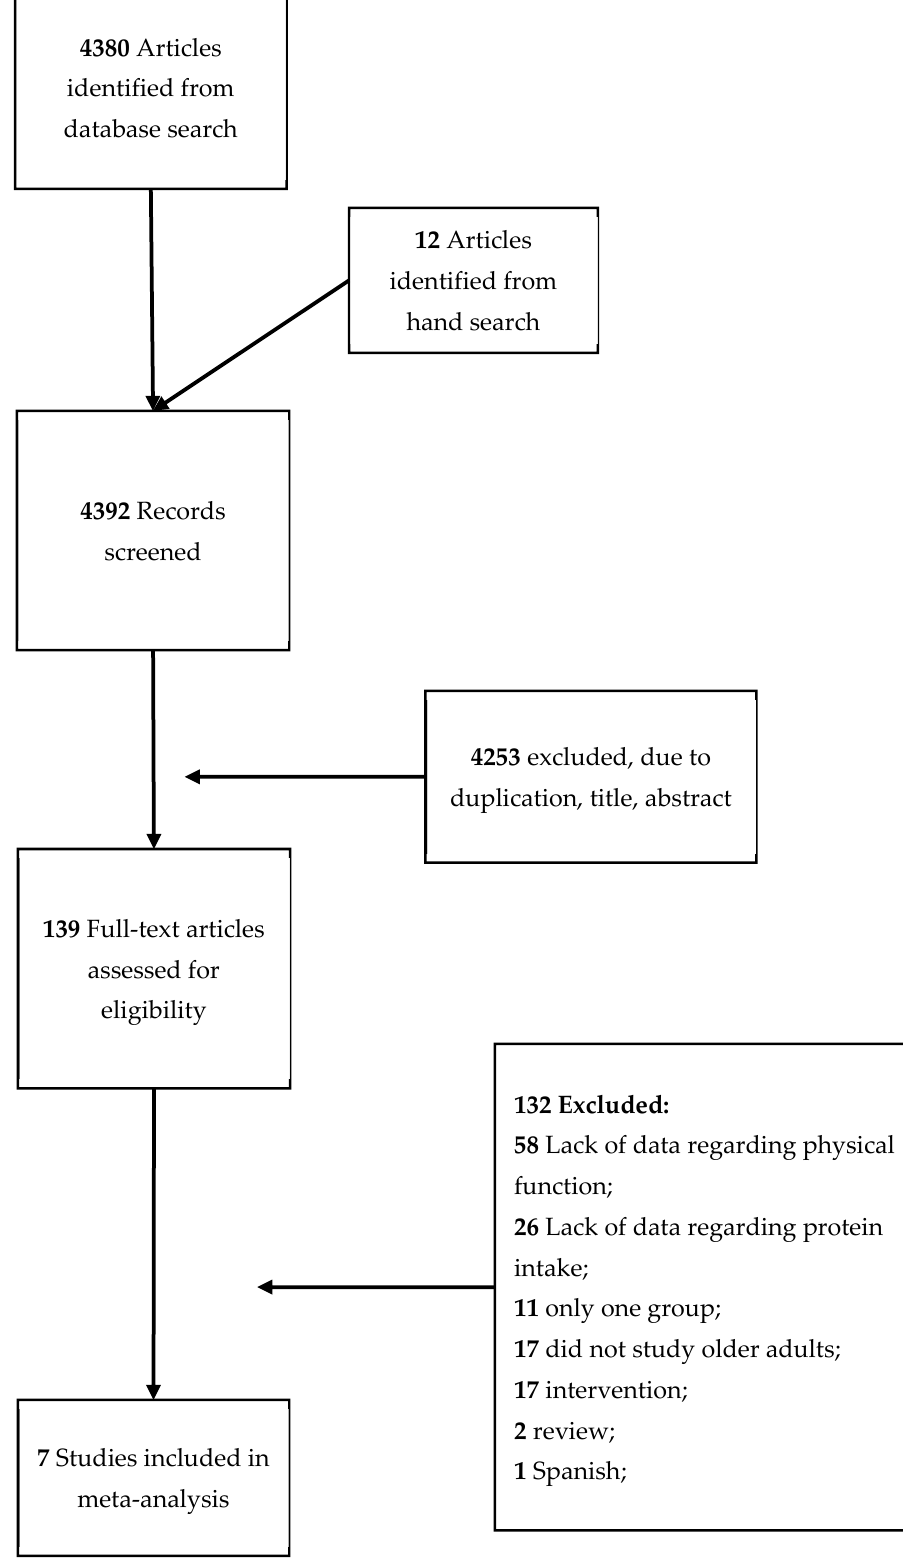
Figure 1. Flowchart of the present study.